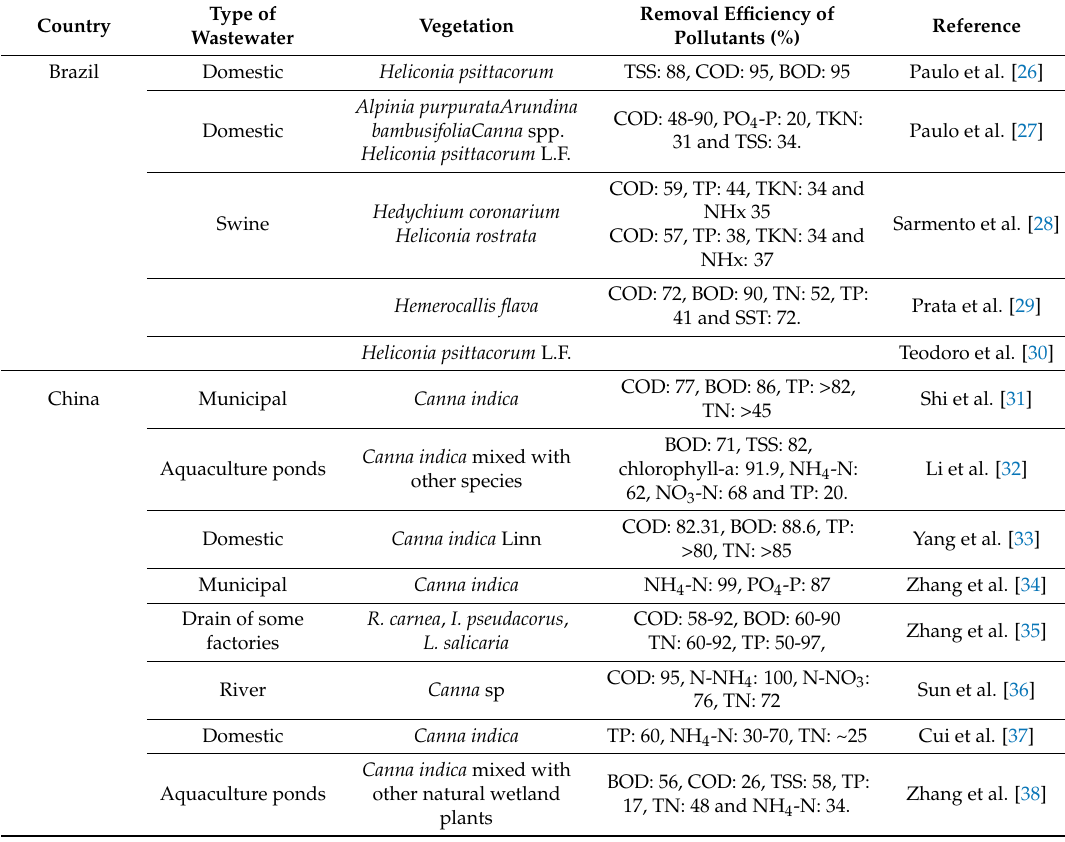
Table 1. Ornamental flowering plants and removal of wastewater pollutants in CWs (constructed wetlands) around the